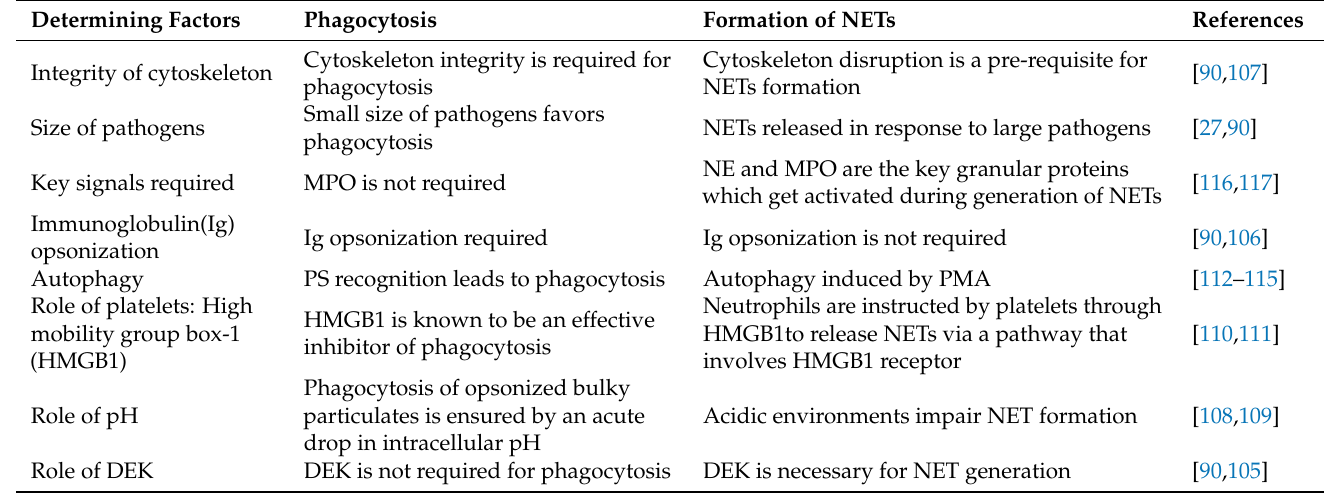
Table 1. Factors that determine neutrophils decision to phagocytosis or form